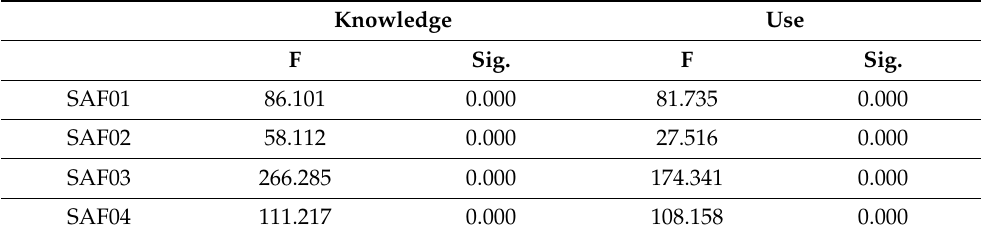
Table A16. ANOVA: knowledge and use of safety